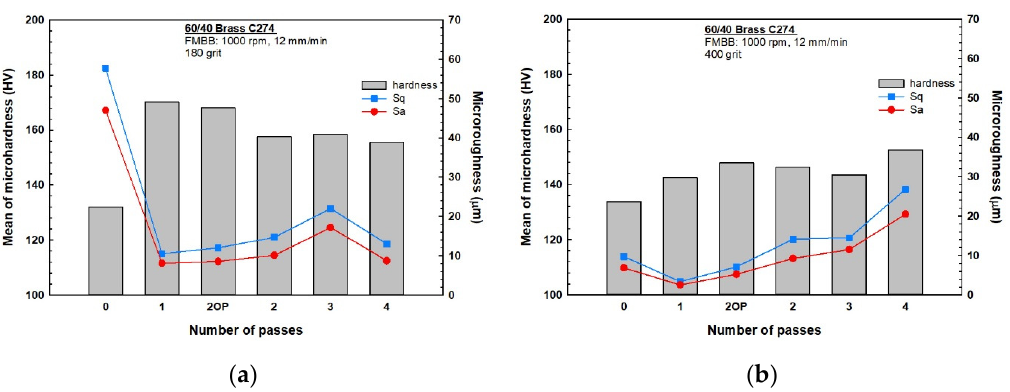
Figure 9. Microhardness and microroughness of samples ground initially with ( a ) 180 grit and ( b ) 400 grit.